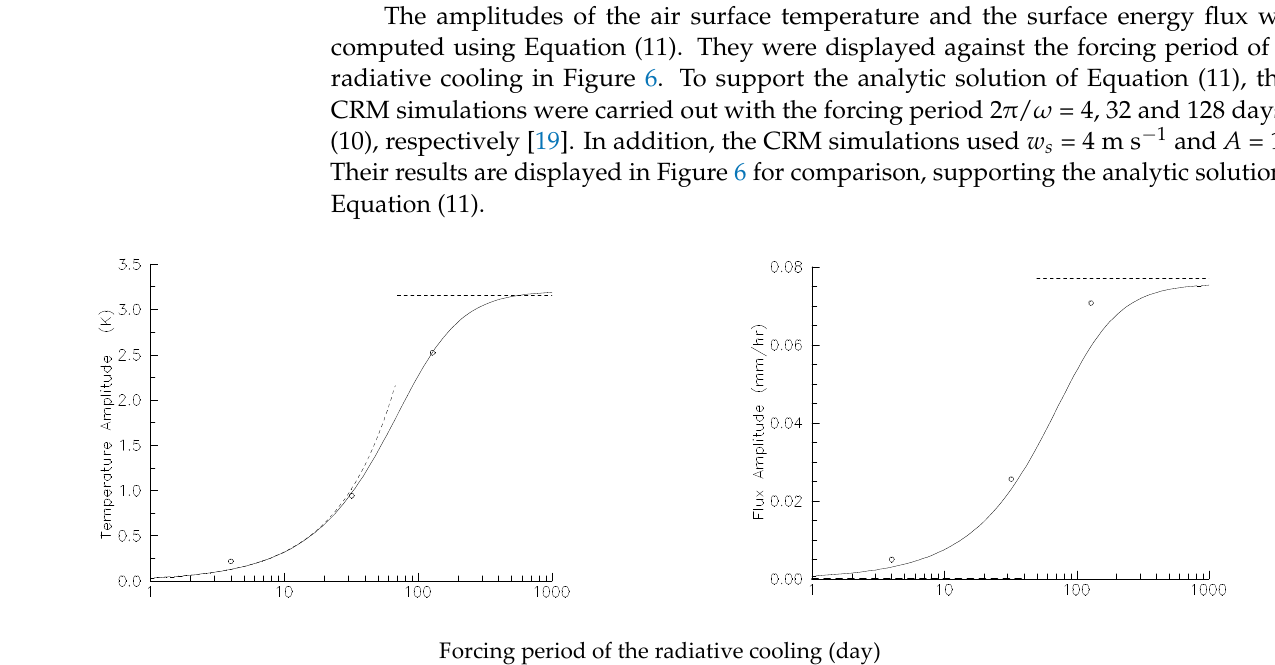
Figure 6. Same as Figure 5 except against the forcing period of the radiative cooling. The dashed lines over the small period denote the active mode where the top entropy flux has no effect on the surface entropy flux; the dashed lines over the long period denote the passive mode where the top entropy flux controls the surface entropy flux via convective clouds.